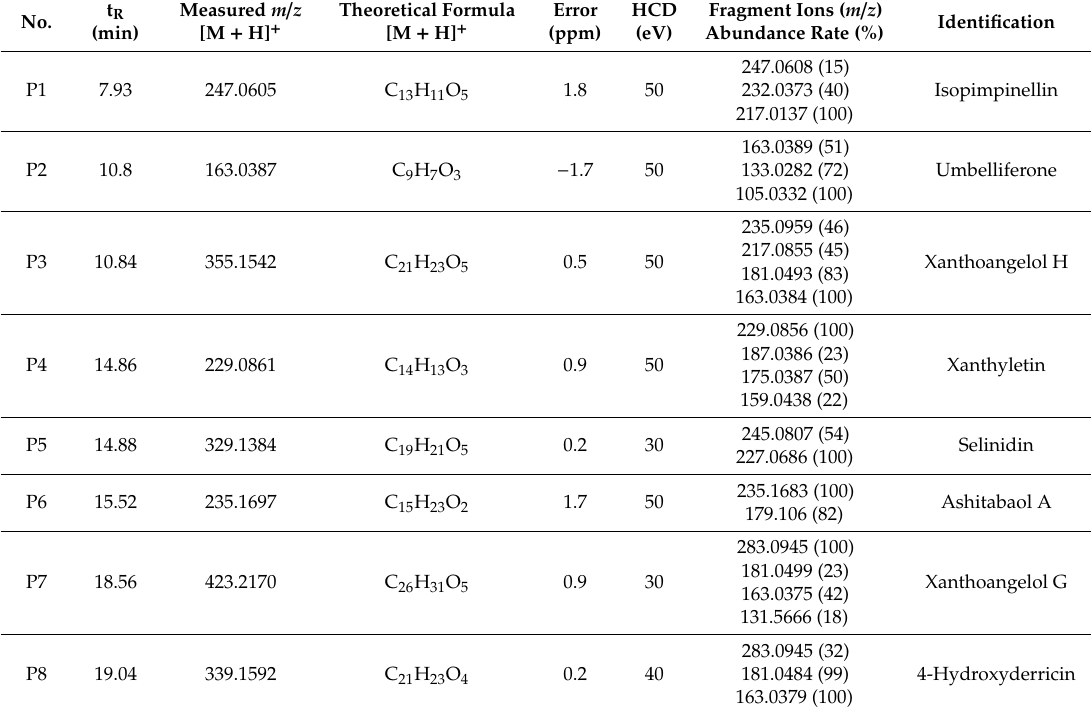
Table 1. Identification of the di ff erent amount of compounds from A. keiskei between the blank and test groups by UPLC-MS / MS in positive ion mode.